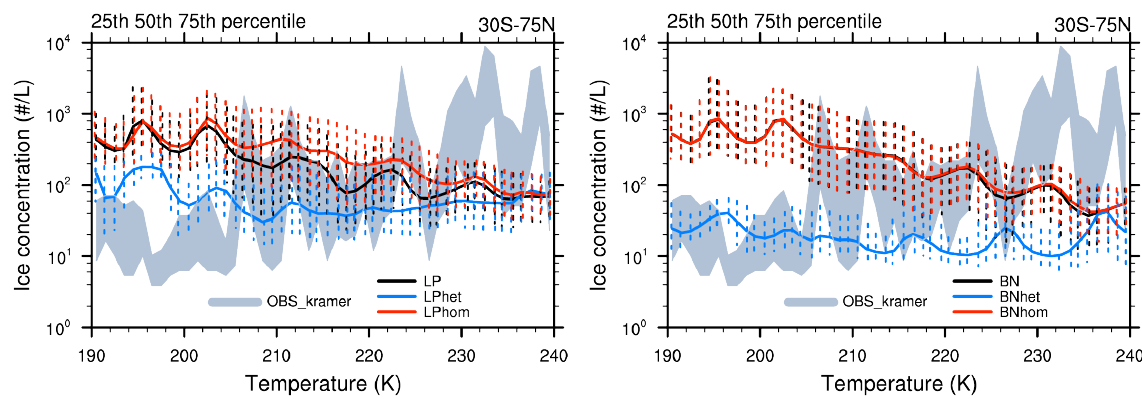
Fig. 5. In-cloud ice crystal number concentration (L − 1 ) versus temperature. Model results are sampled every 3 hours over tropical, mid- latitude and Arctic regions including the observation locations reported in Kr¨amer et al. (2009). The 50% percentile (solid line), 25% and Figure 5. In-cloud ice crystal number concentration (L -1 ) versus temperature. Model 75% percentiles (error bar) are shown for each 1K temperature results are sampled every 3 hours over tropical, mid-latitude and Arctic regions including the observation locations reported in Krämer et al. [2009]. The 50% percentile (solid line), 25% and 75% percentiles (error bar) are shown for each 1 K temperature bins.